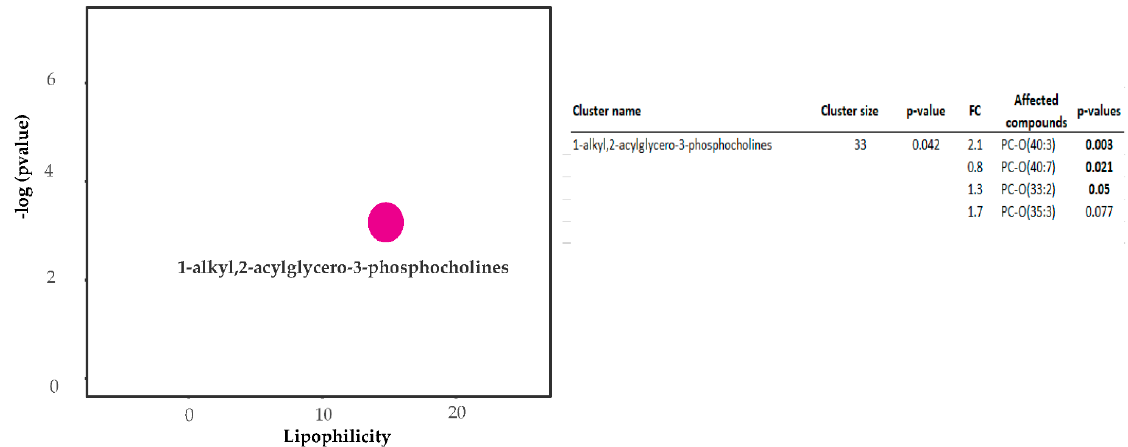
Figure 3. ChemRICH analysis plot for hippocampus from pigs fed six serving of WBM. ChemRICH impact plot for pigs fed six servings of WBM vs. pigs fed control diet with corresponding statistic table showing affected compounds within the alkyl,2-acylglycero-3-phosphocholines. p -values < 0.05 in bold